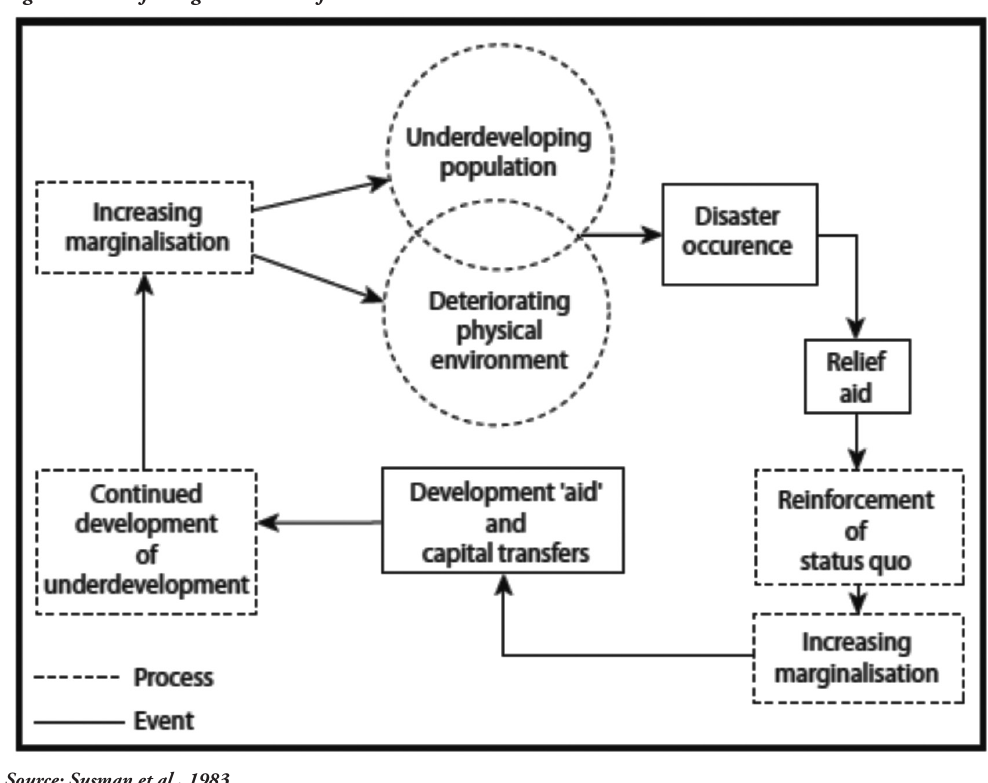
Fig 1. Process of marginalization of disaster victims